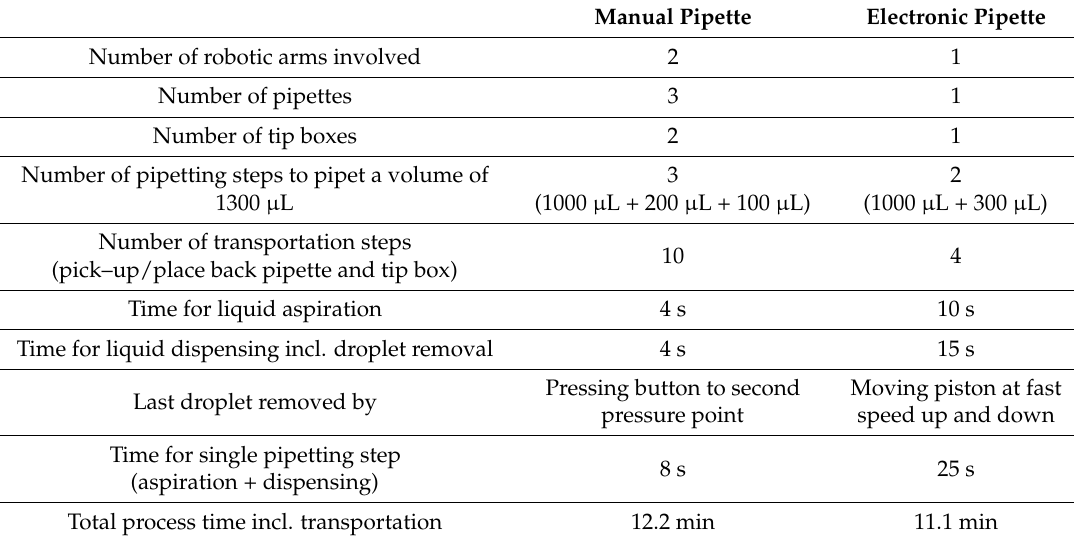
Table 9. Process comparison for pipetting using manual and electronic pipettes.